Question: Briefly state, in one sentence, what is plotted here.
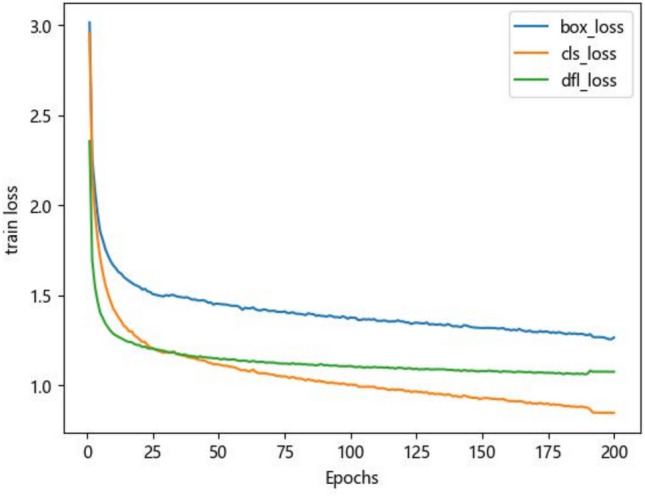
Answer: Loss with varying epochs during model training. .